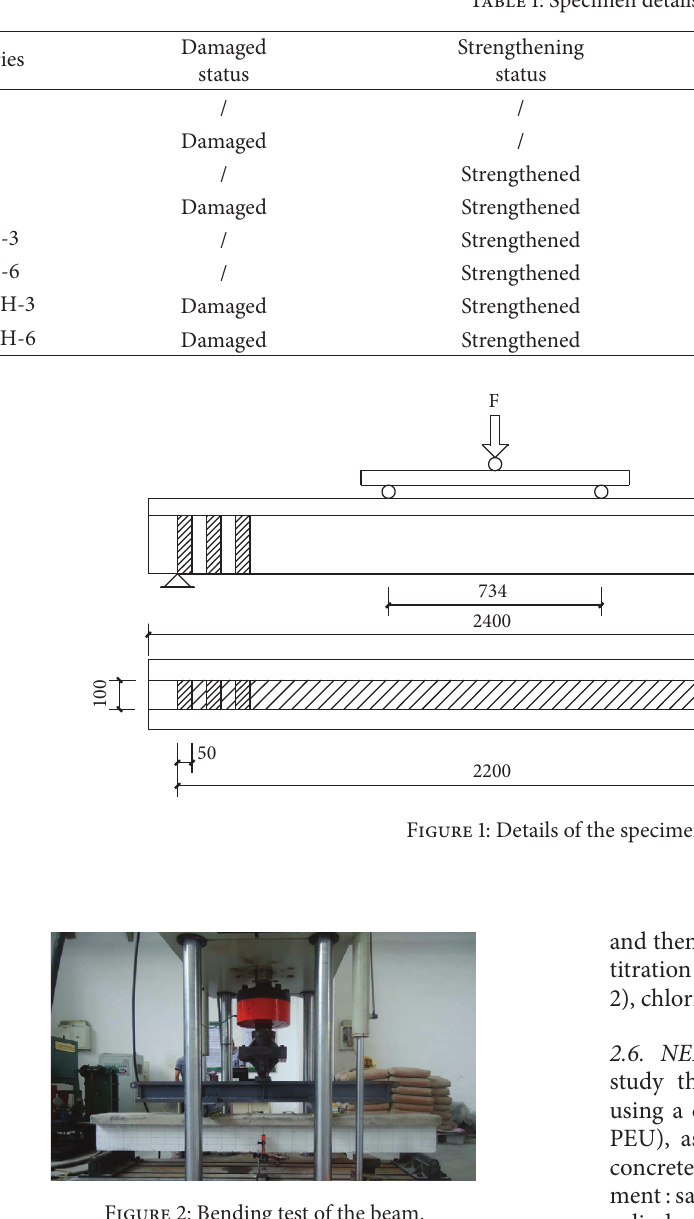
Figure 2: Bending test of the